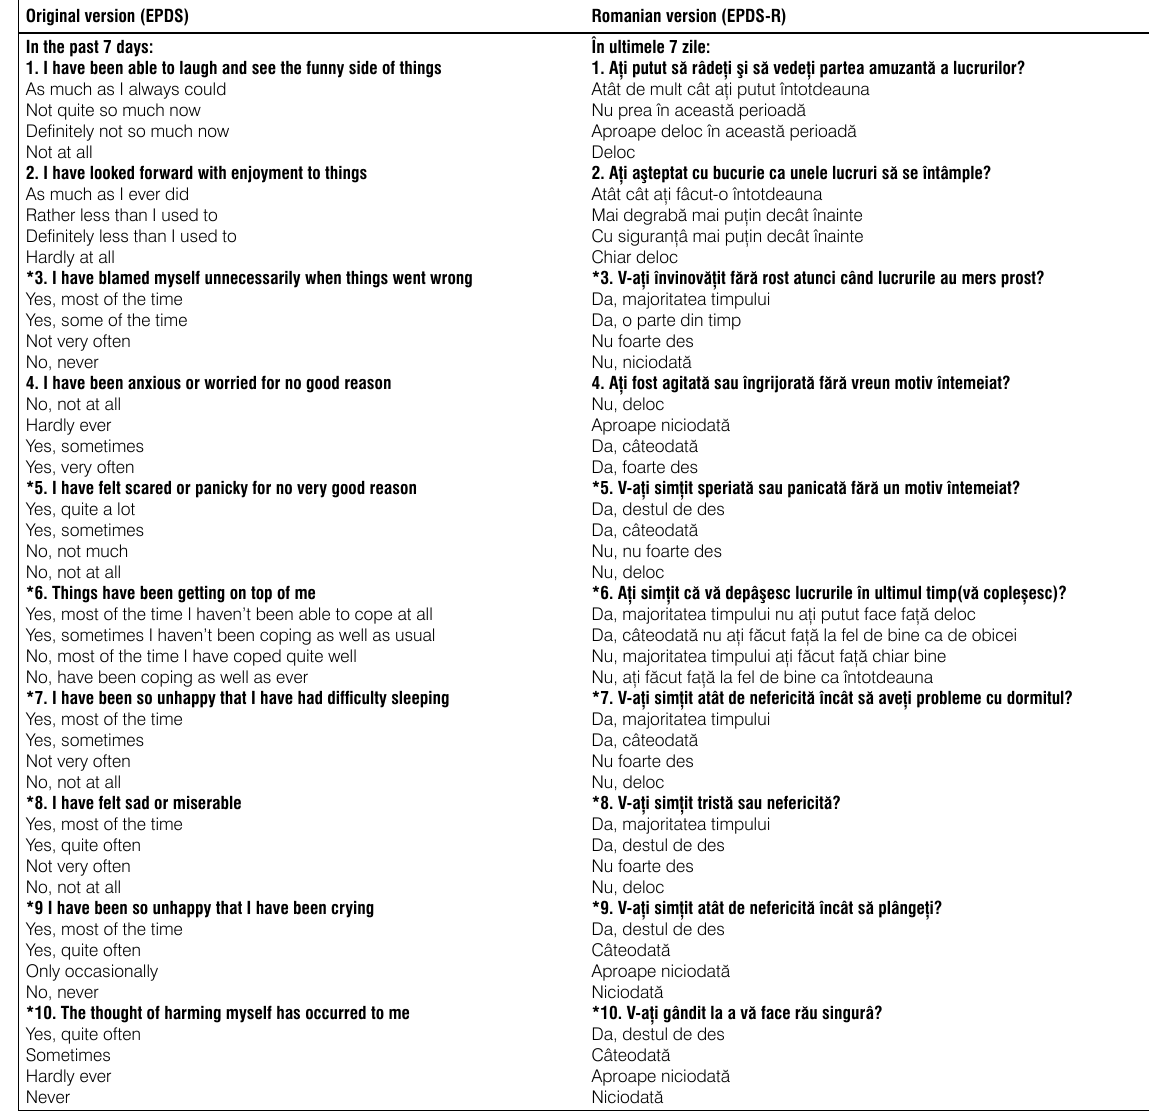
Table 1. Original English and Romanian versions of EPDS